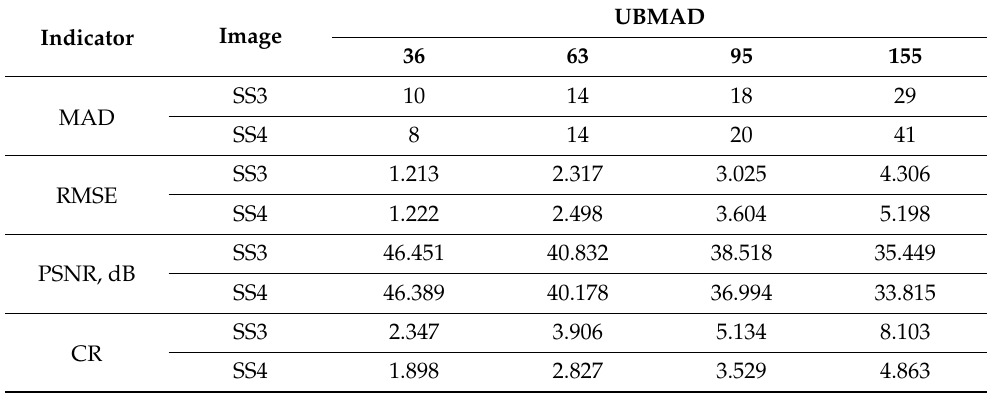
Figure 13. Processing of the test images SS3 ( a ) and SS4 ( b ): dependence of CR on PSNR. Table 4. Results of compressing SS3 and SS4 using DAC with DAT1 of the depth 5.